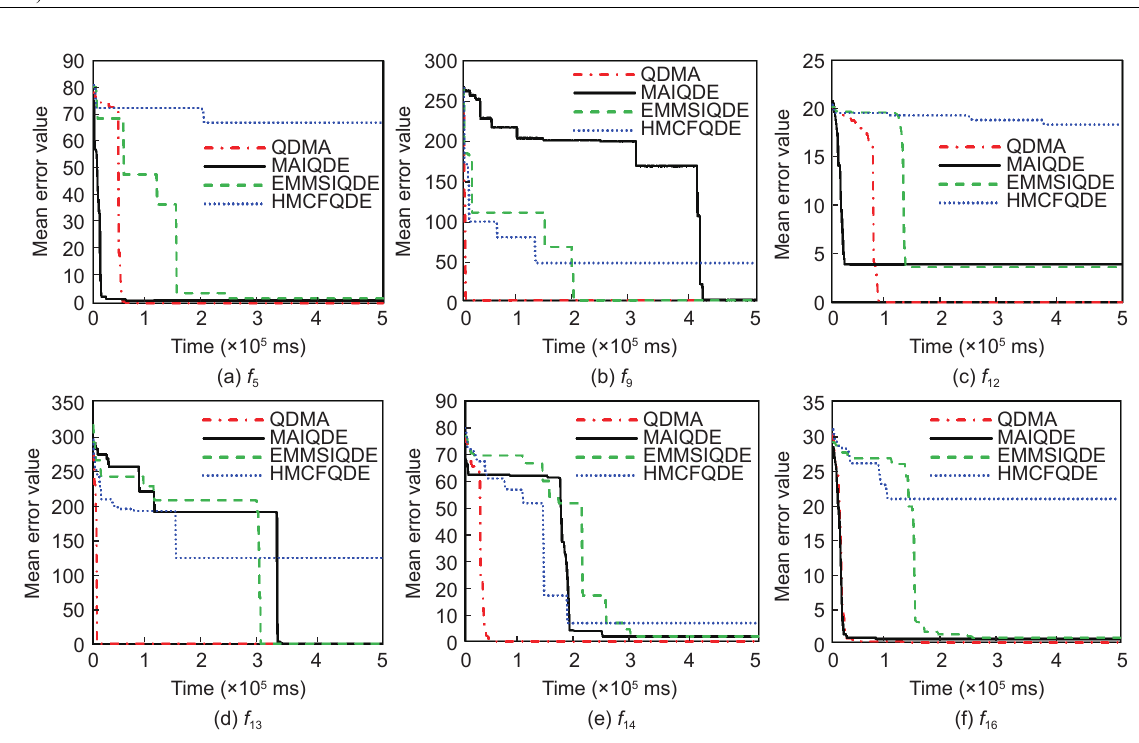
Fig. 5 Convergence graphs of QDMA and QEA variants on 50 D